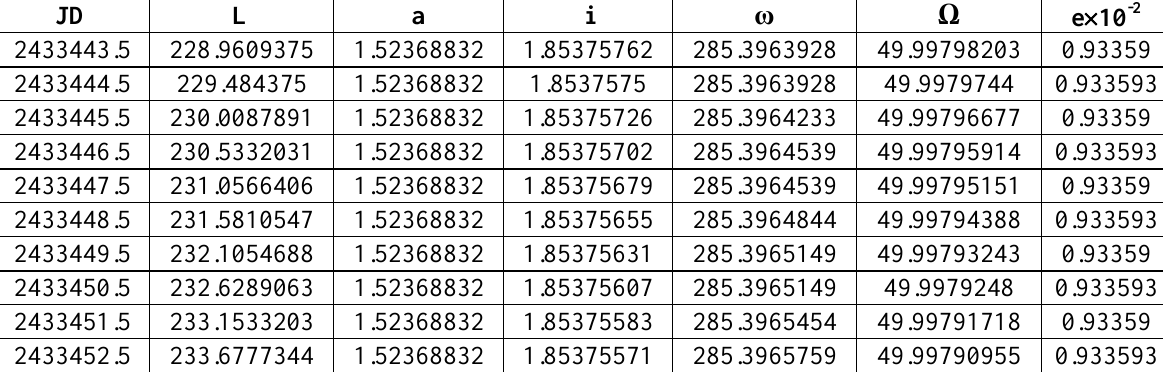
Table 1: The values of Orbital elements and Julian Date for one period.